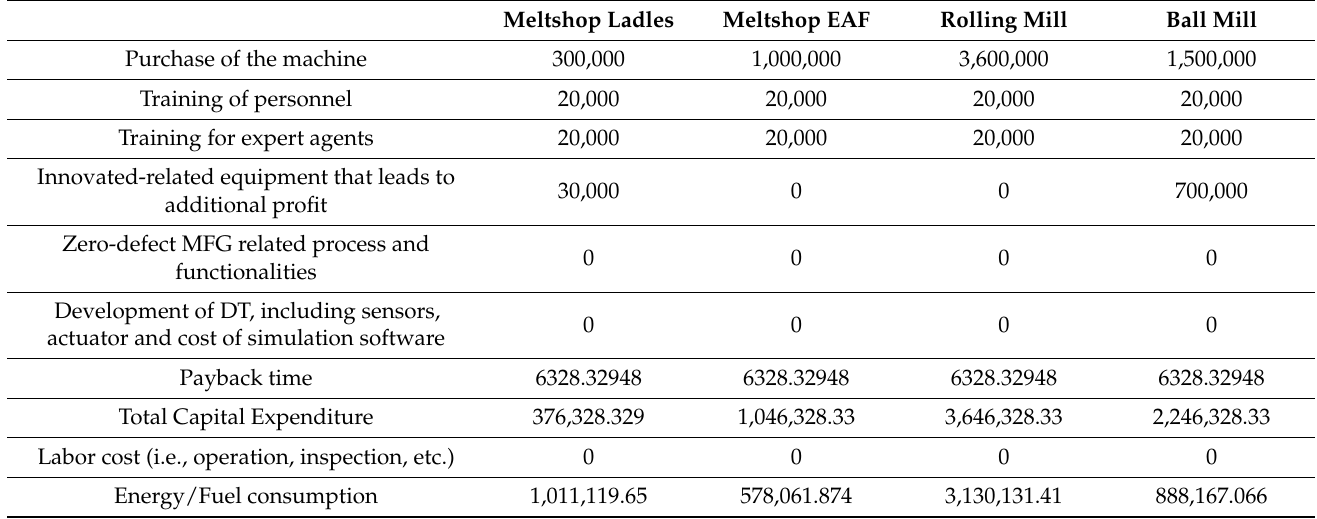
Table A3. Costs for energy efficient